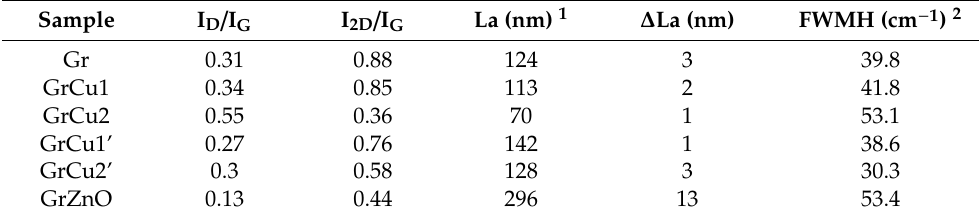
Table 2. Raman intensity ratios and in plane crystallite size.